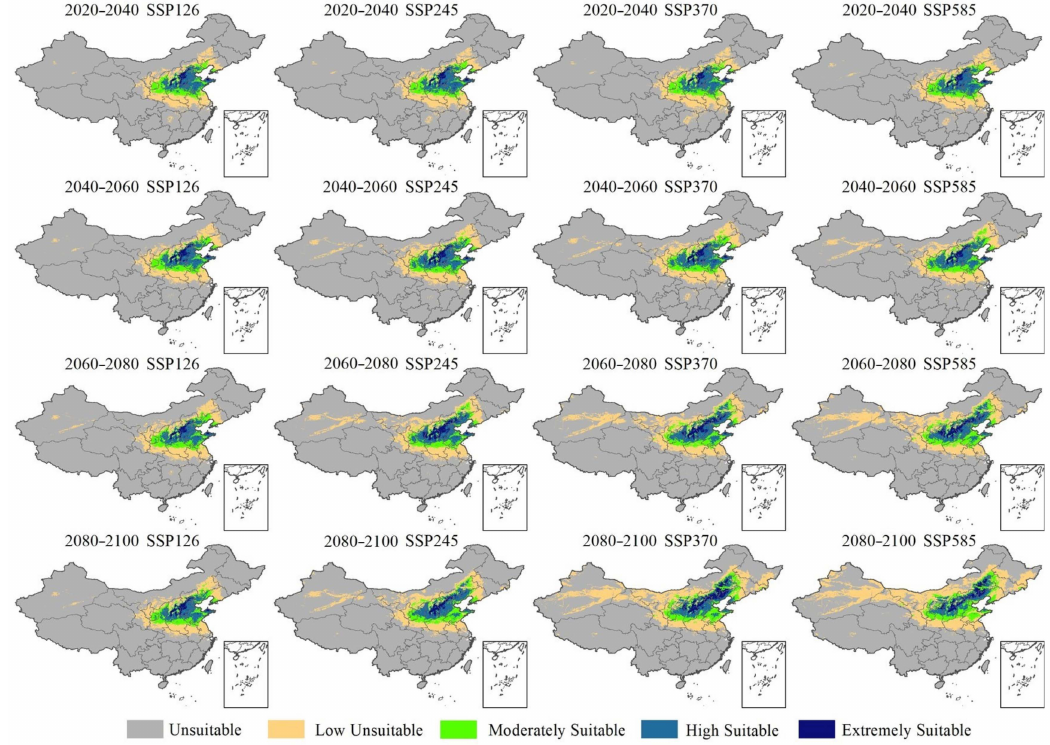
Figure 5. Distribution map of climatically suitable areas of P. bretschneideri under future climatic conditions in China.